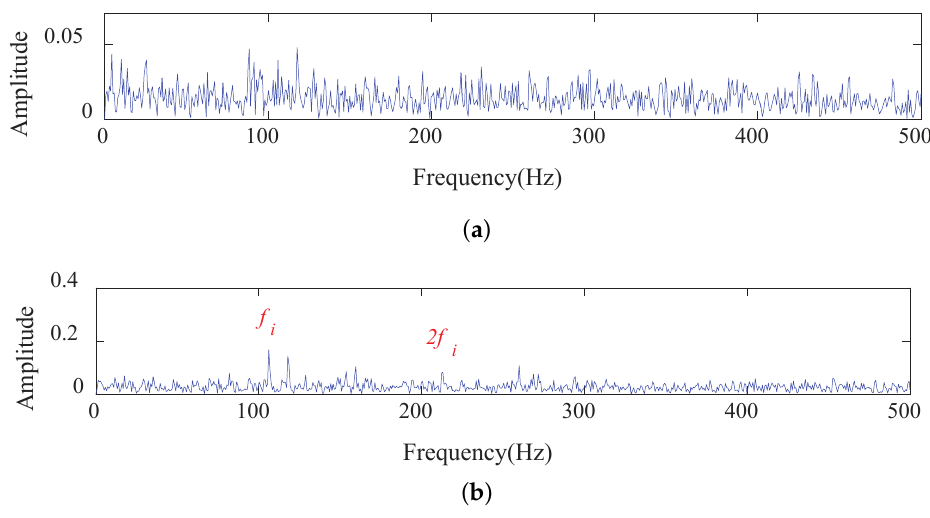
Figure 15. Results of TQWT: ( a ) High oscillatory component. ( b ) Low oscillatory component.